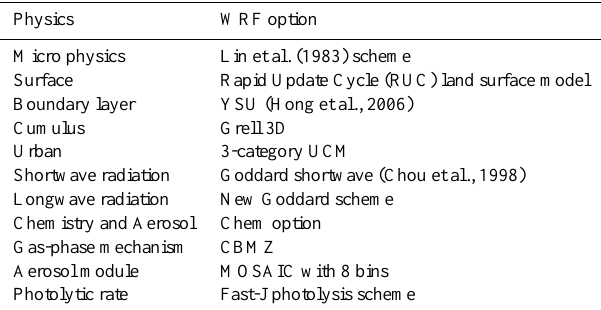
Table 2. Configurations of